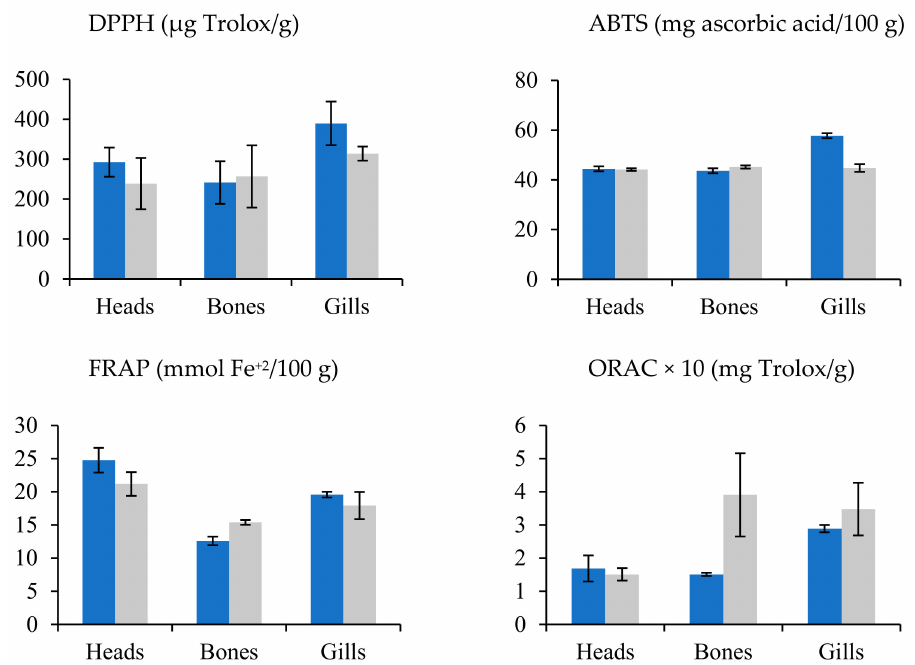
Figure 3. Mean values ± SEM. Antioxidant capacities in residues (bones, gills, and heads) of sea bream (blue) and sea bass